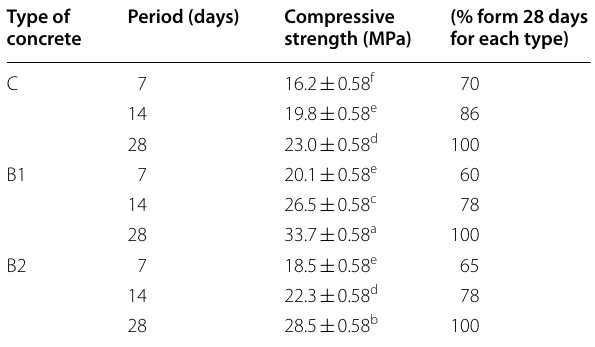
Table 3 Ratio of the compressive strength for each period (7